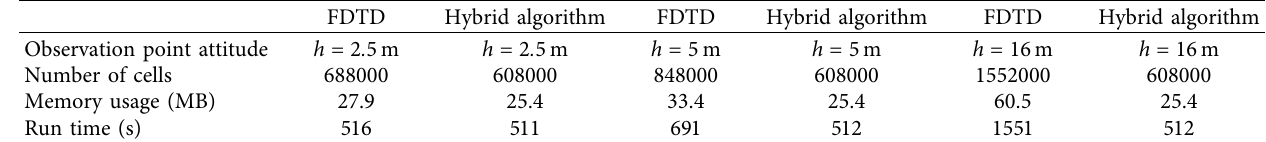
Table 1: Computation costs of the hybrid algorithm and the FDTD method for the TE case. FDTD Hybrid algorithm FDTD Hybrid algorithm